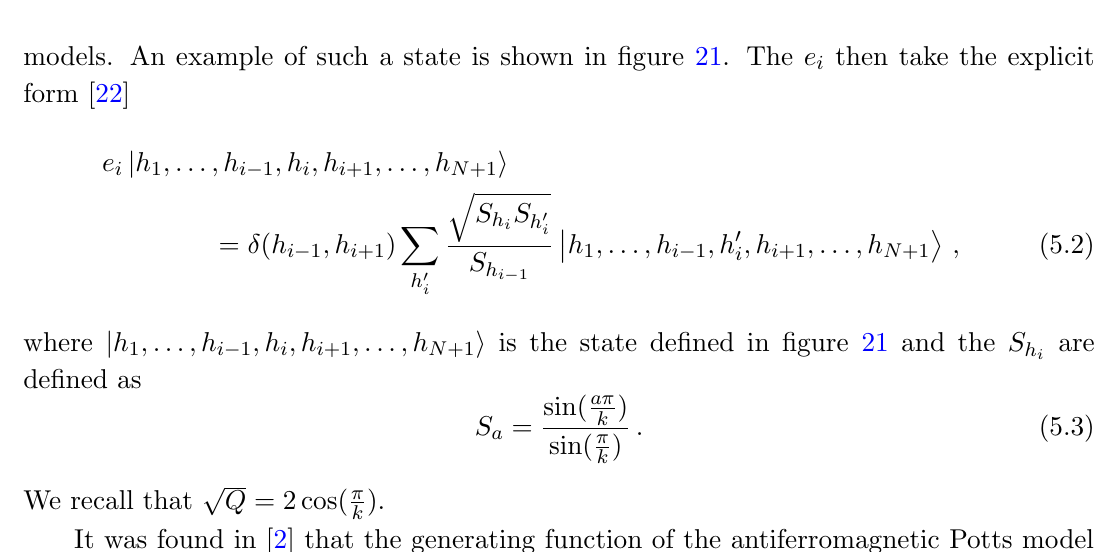
Figure 21 . The state j h 1 h 2 h 3 h 4 h 5 h 6 h 7 i